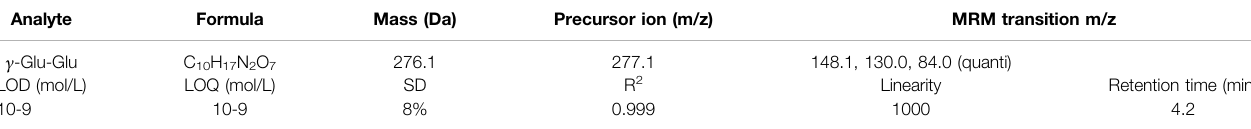
TABLE 1 | Mass spectrometric parameters: MRM parameters, chromatographic attributes, and quantitative response of γ -Glu-Glu compounds in standard samples.